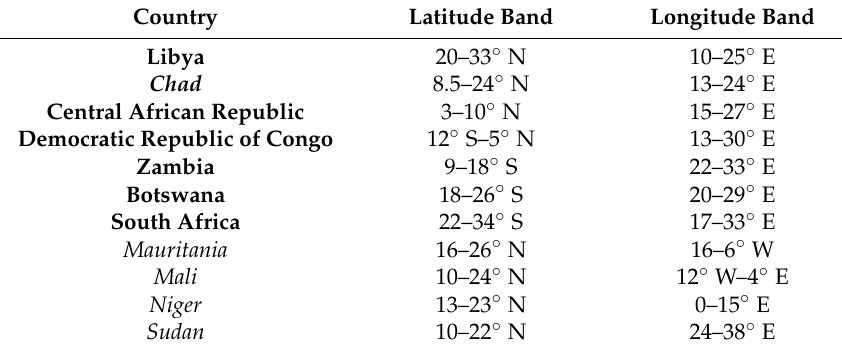
Table 2. Regions used for climate variable calculations for modelled countries (bold—N-S transect; italics—W-E